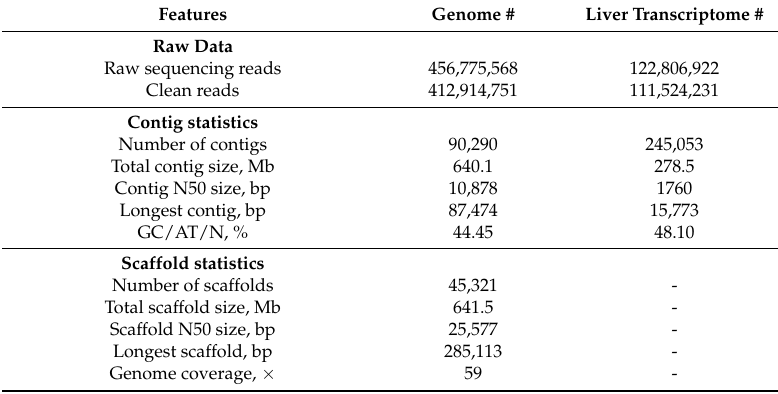
Summary of genome and liver transcriptome statistics of the European sardine, Sardina pilchardus